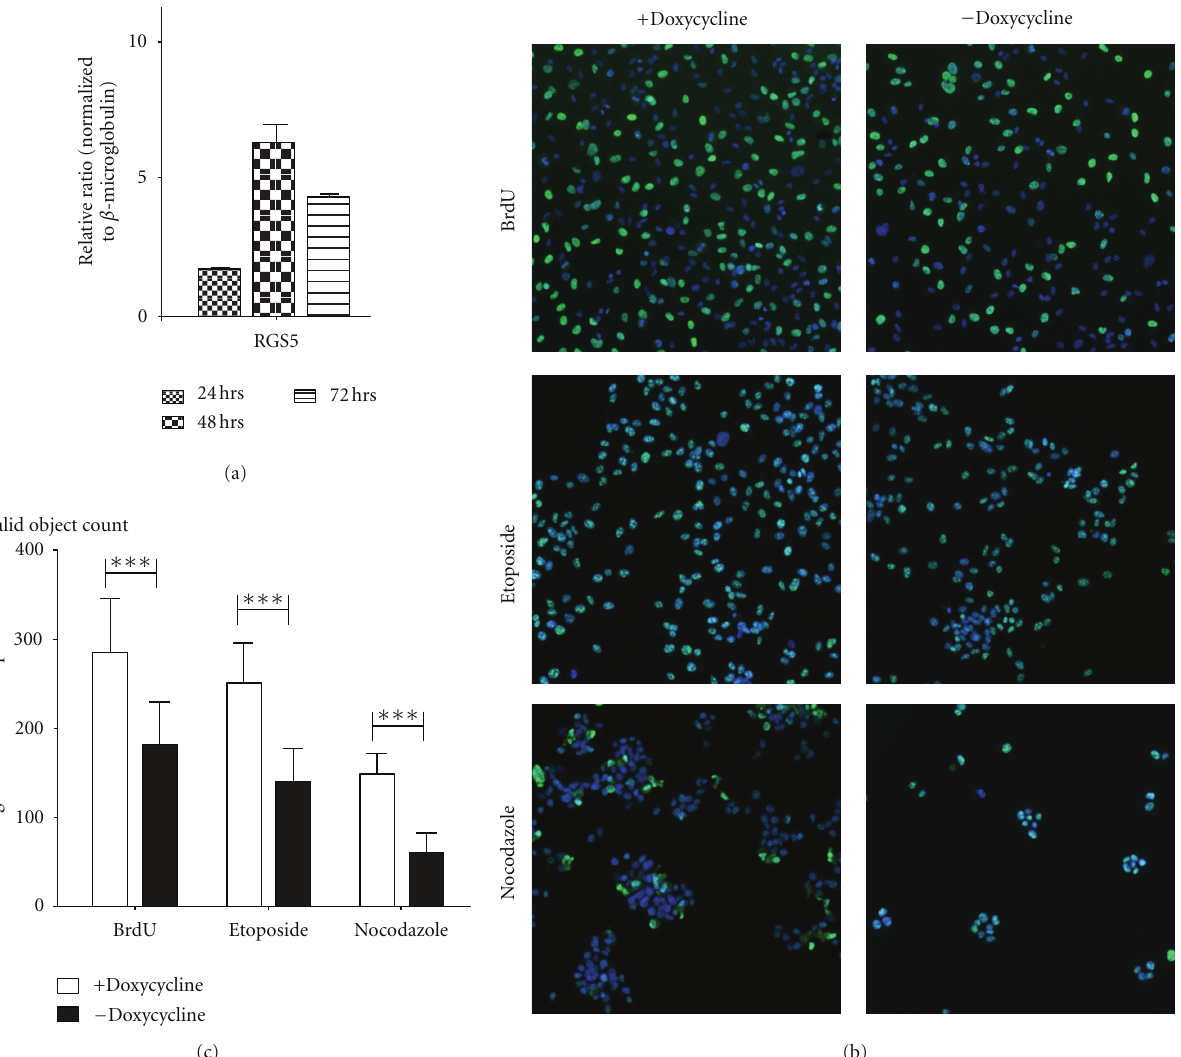
Figure 1: RGS5 inducible expression in HeyA8-MDR cells reduces proliferation. (a) HeyA8-MDR pTet dual RGS5 inducible cells were seeded in a multiple 6-well and cultured in medium with tetracycline-free fetal bovine serum without doxycycline for 24, 48, and 72hours. Cells were harvested; the RNA was isolated and processed for qRT-PCR using primers to detect RGS5 expression resulting from the Tet-O ff Advanced inducible system. Without the presence of doxycycline or other members of the tetracycline antibiotics, RGS5 expression was observed. (b) HeyA8-MDR cells were plated in a 96-well plate at a density of 3,000 cells per well. Half of the plate was grown in medium containing regular FBS with doxycycline and the other half containing doxycycline-free media. Cells were then incubated at 37 ◦ C for 72 hours to allow for RGS5-inducible gene expression. Prior to fixation, HeyA8 MDR cells were pulse-treated for 1hour with BrdU and then treated for 4hours with the indicated cell cycle arrest compounds. Cells were then fixed and stained for proliferation and nuclear morphology. Representative images taken using the Cellomics ArrayScan VTI HCS Reader and are shown here. (c) High-content scanning analysis software was used to determine the average number of cells per